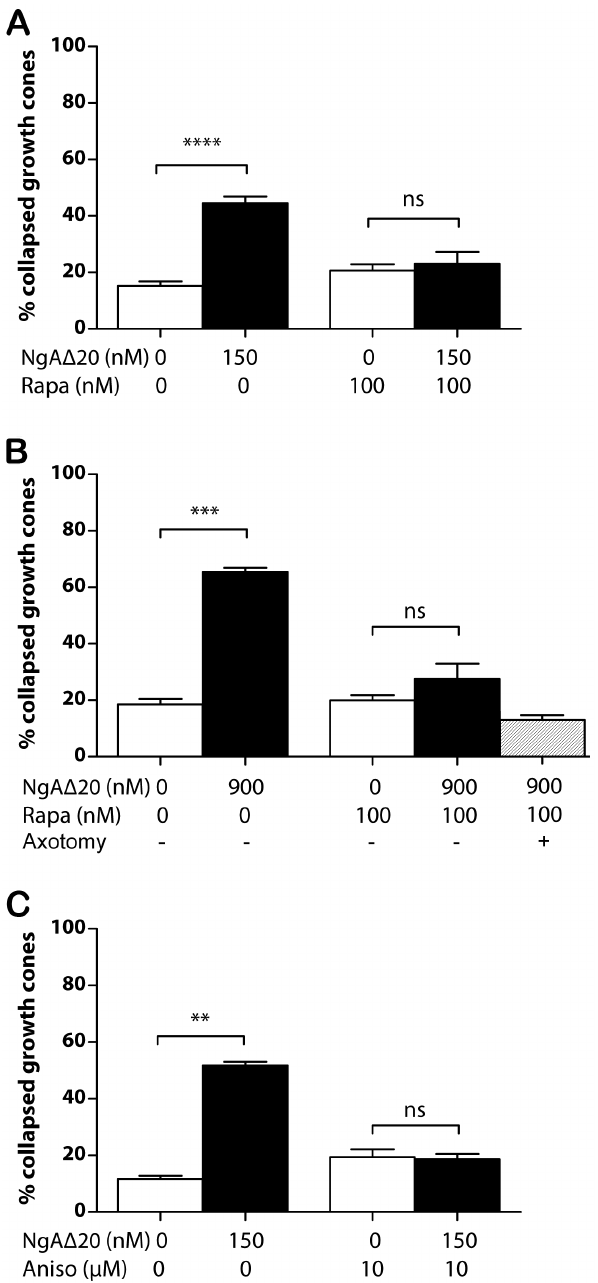
Figure 1. Dependence of Nogo-A- D 20-induced growth cone collapse on protein synthesis. A/ Nogo-A- D 20–induced collapse remains at control levels in the presence of 150 nM rapamycin. B/ Nogo- A- D 20-induced collapse remains at control levels in the presence of 900 nM rapamycin. Collapse is not affected by axotomy prior to rapamycin exposure. C/ Nogo-A- D 20–induced collapse remains at control levels in the presence of 10 m M anisomycin.